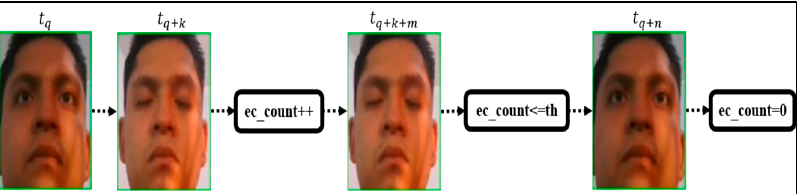
Figure 8. An example of driver’s normal blinking. If the closed eye continues m frames and m is smaller than the threshold “th”, then the driver performs his/her normal blinking.